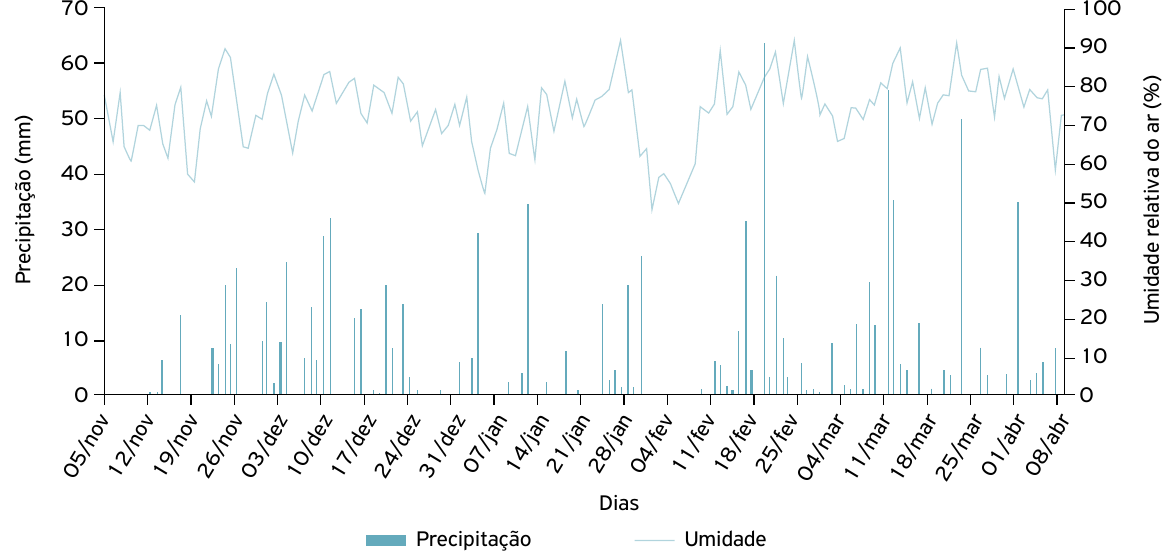
Figura 2. Precipitação pluvial e umidade relativa do ar, a cada sete dias, durante o período de condução do experimento. Jataí, Goiás,